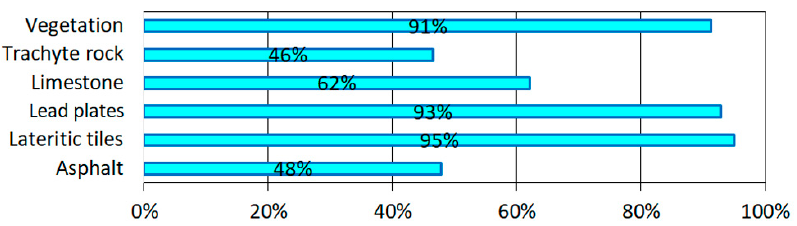
Figure 10. The percentage of RMS k values due to the spatial and spectral characteristics of the MIVIS image, the reference endmember set and LMM.